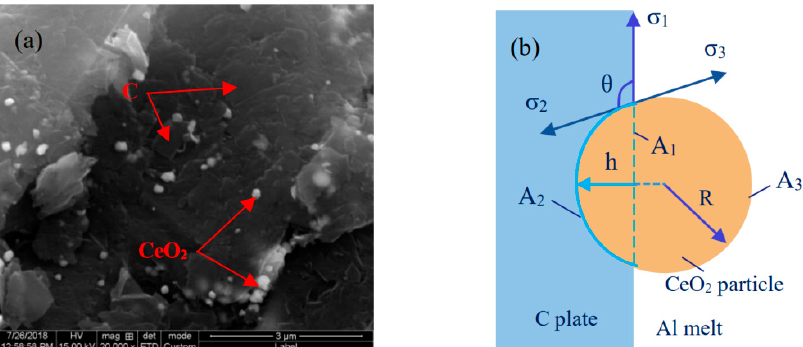
Figure 8. SEM image and model diagram of CeO 2 particles adsorbed on the surface of C sheet in aluminum melt: ( a ) SEM spectrum of 5# pressing block at reaction time of 50 s; ( b ) schematic diagram of the model.